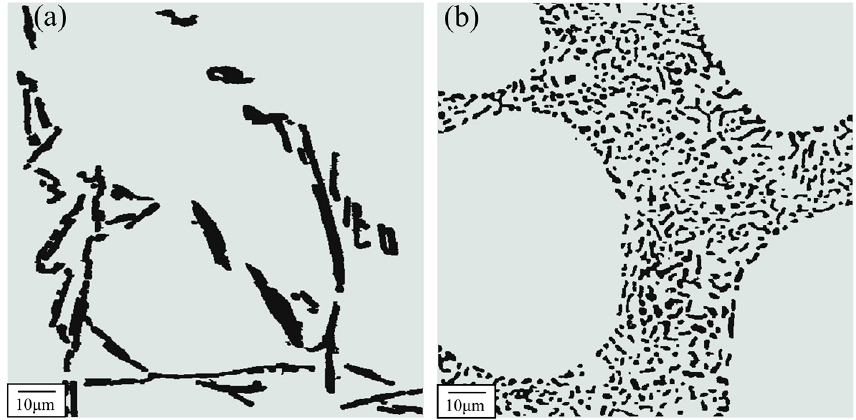
Figure 3. The microstructure of eutectic Si in Al-7Si alloys. ( a ) Unmodified, ( b ) modified [96].